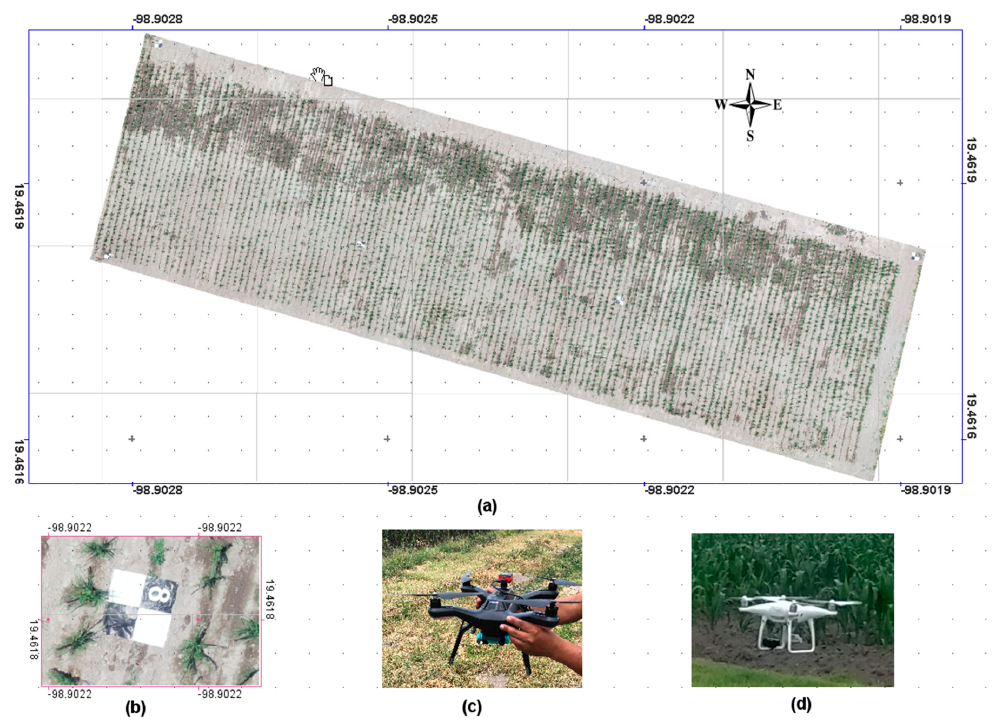
Figure 1. ( a ) Established corn experimental field; ( b ) Ground control points (GCP); ( c ) 3DR Solo UAV; ( d ) DJI Phantom UAV.